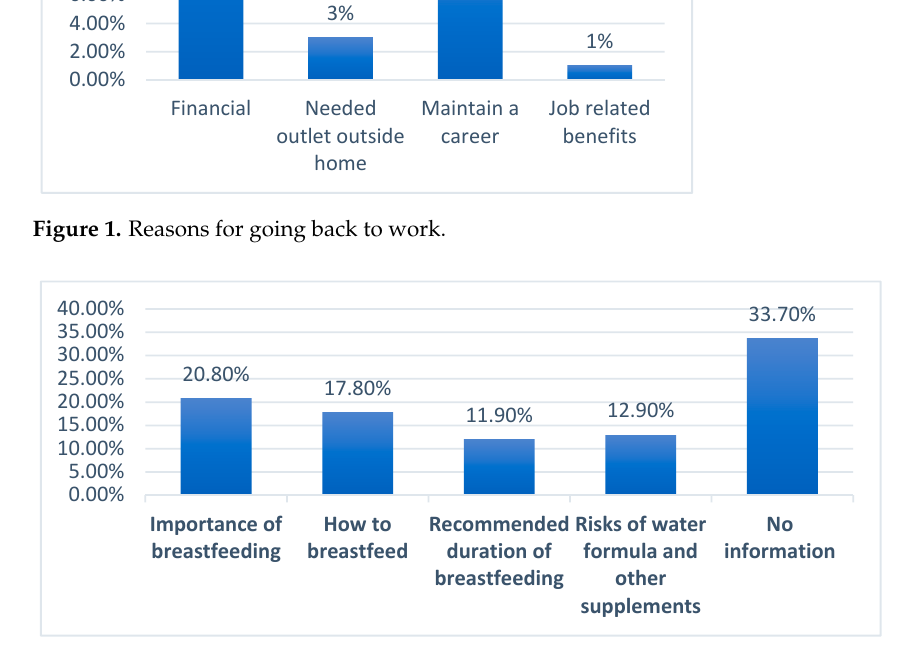
Figure 1. Reasons for going back to work.